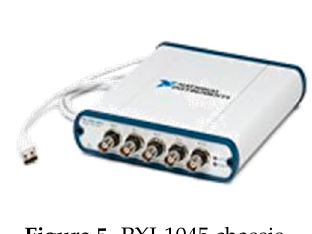
Figure 5. PXI-1045 Figure 5. PXI-1045 chassis. Figure 5. PXI-1045 chassis. Figure 5. PXI-1045 chassis.